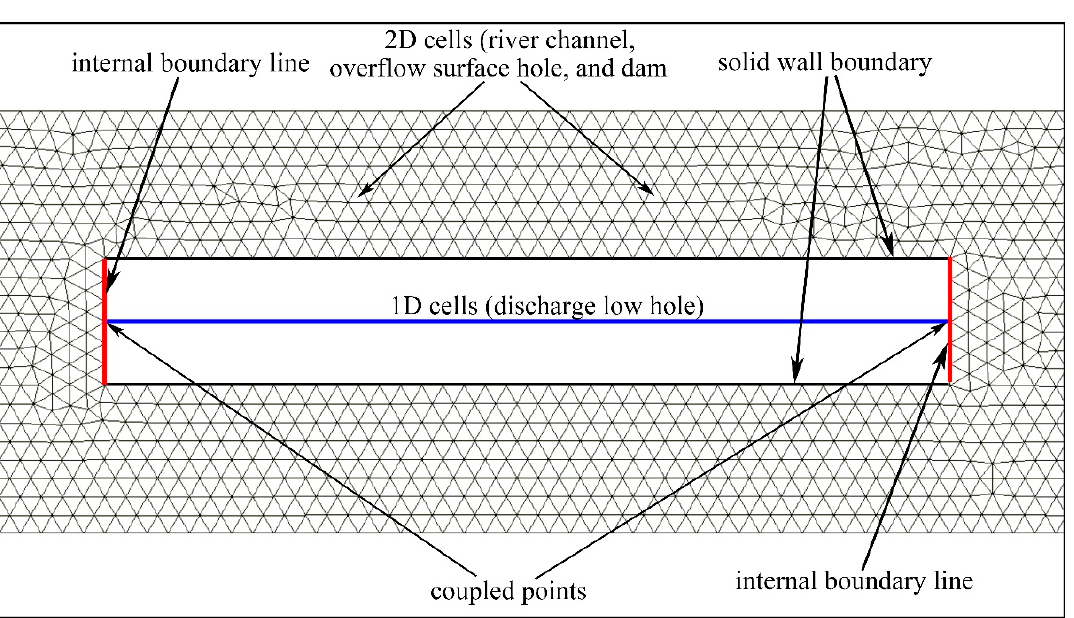
Figure 1. Schematic of model coupling.